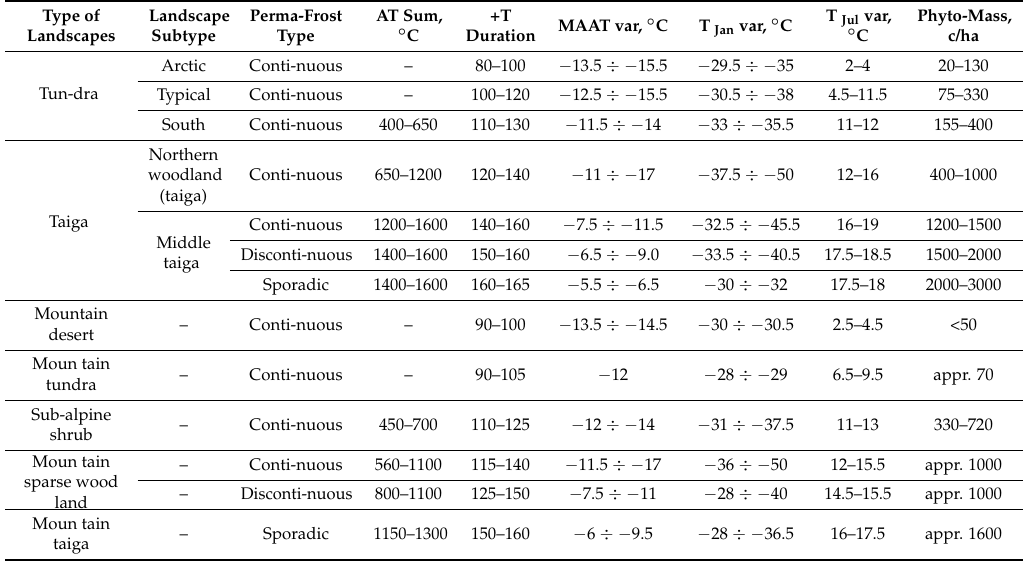
Table 2. Characteristics of Yakutian means types of landscapes